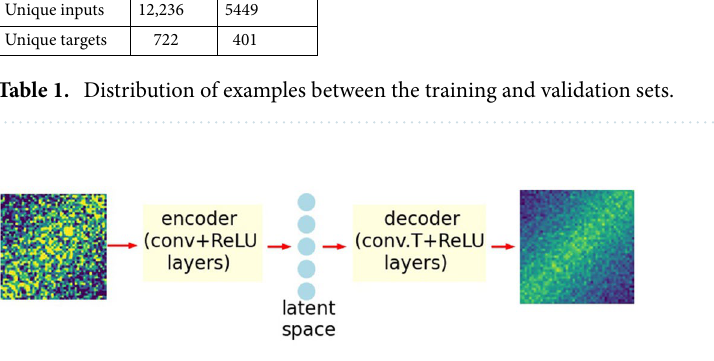
Figure 2. Architecture of the CNN-ED model. The input and the output images have the same intensity